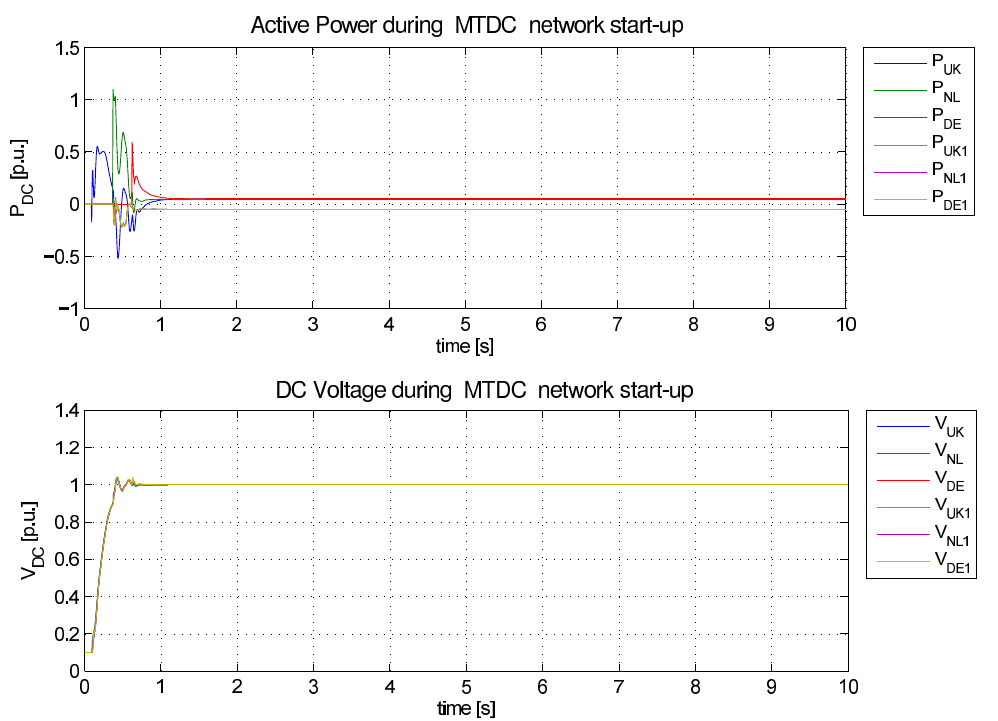
Figure 11. Results from Case Study 1: MTDC